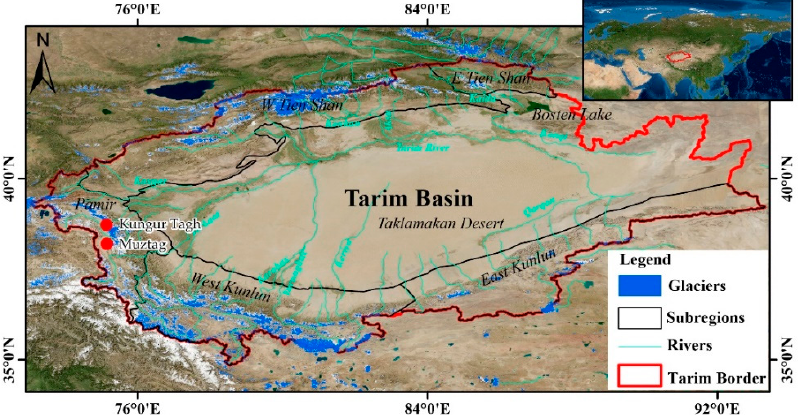
Figure 1. Map of the Tarim Basin. Glacierized areas and the boundary of the Tarim Basin are indicated. Red dots are the Muztag and Kungur Tagh locations.